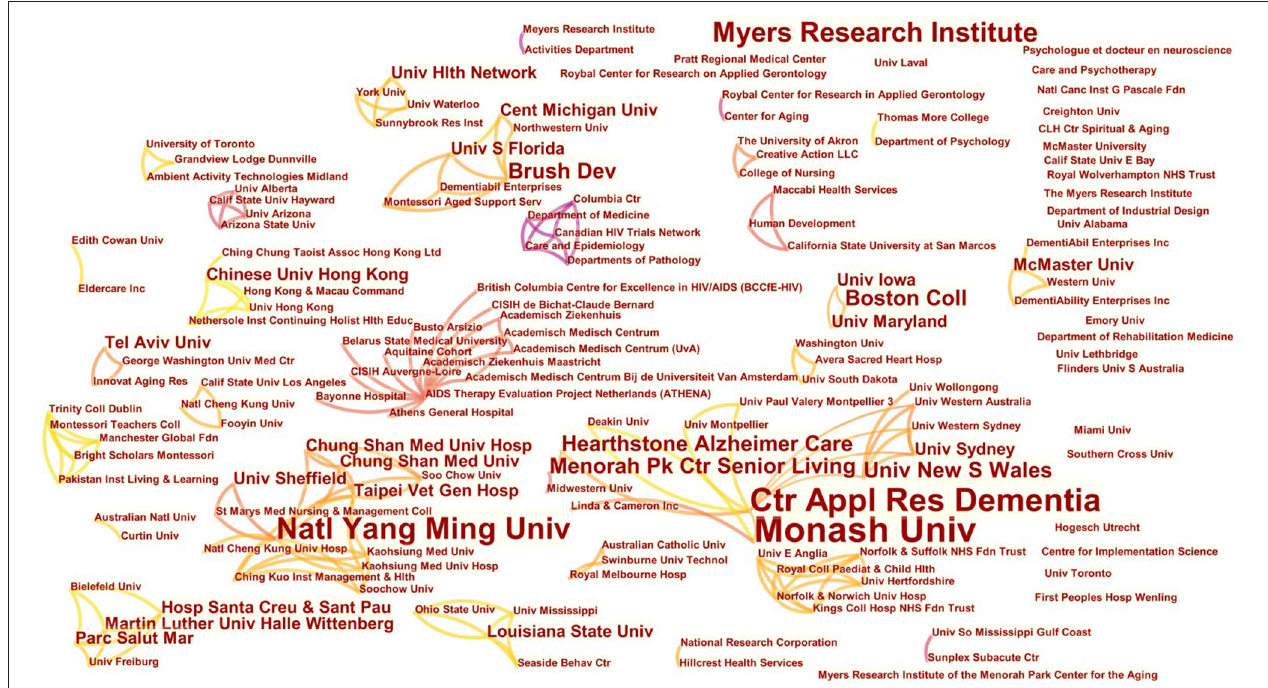
FIGURE 4 | Distribution of institutional publications in the English-language on Montessori approach to interventions for patients with dementia from 2000 to 2021.